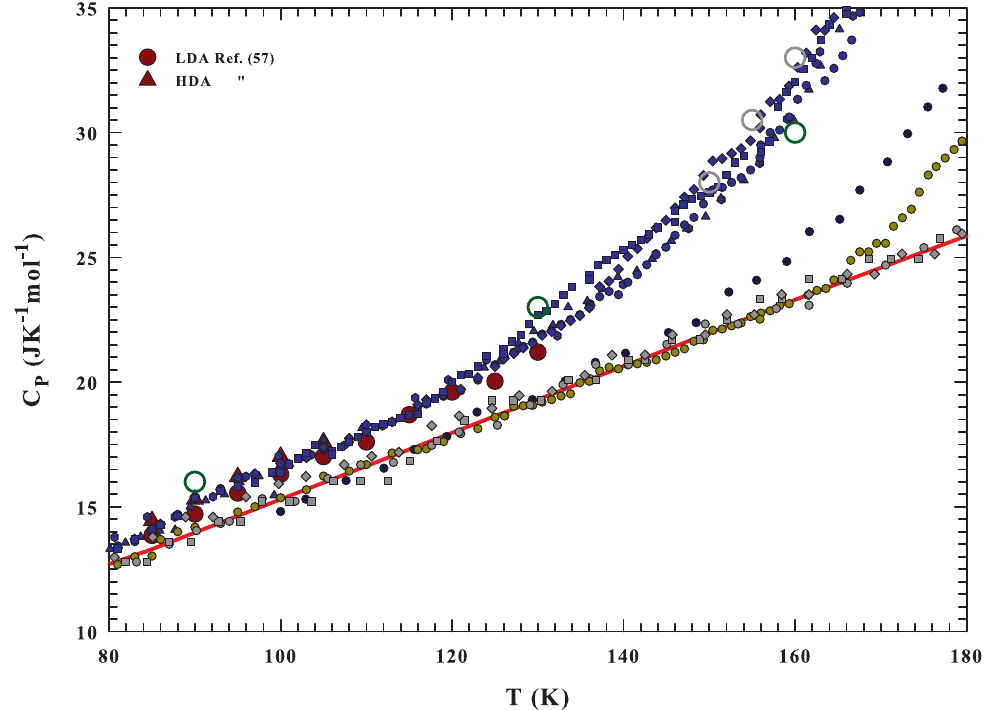
Figure 2. The C P data of Figure 1 reported in an enlarged temperature scale (80–180 K). The values of LDA and HDA are reported as dark red circles and triangles, respectively [57].